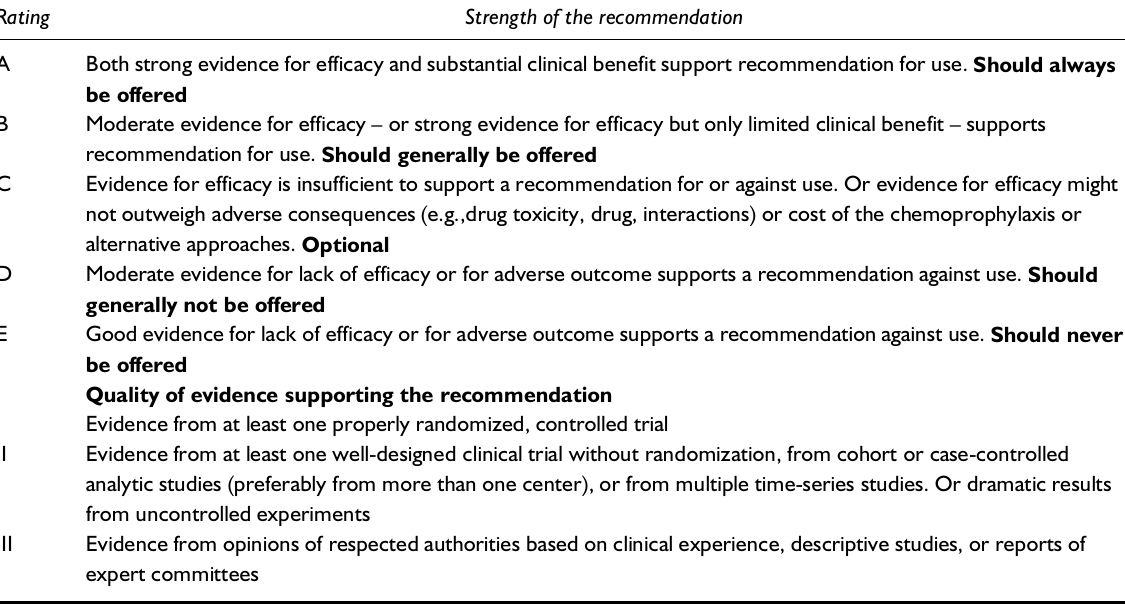
Table 1 System used to rate the strength and quality of evidence supporting recommendations for prevention of opportunistic infections in persons infected with